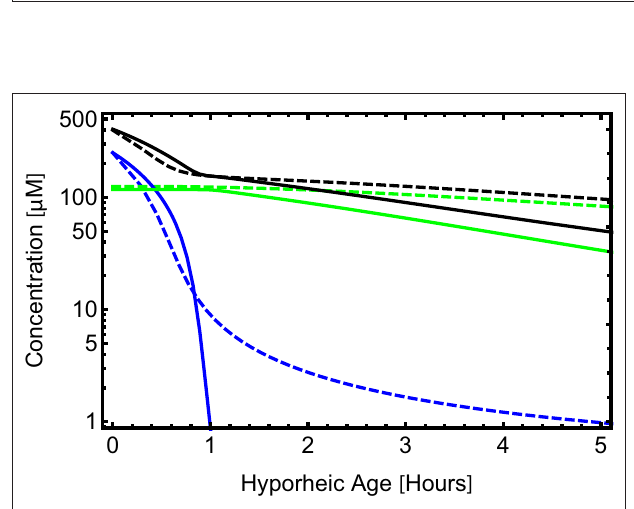
FIGURE 4 | Percentage of incoming nitrate removed vs. travel distance for the ADELS model (solid curve) and the mTSM model (dashed curve) for reference case assumptions (A) and a variant case with channel discharge of 10 m 3 /s (B) . The blue line is a first-order estimate that neglects reactant depletion and oxygen inhibition.